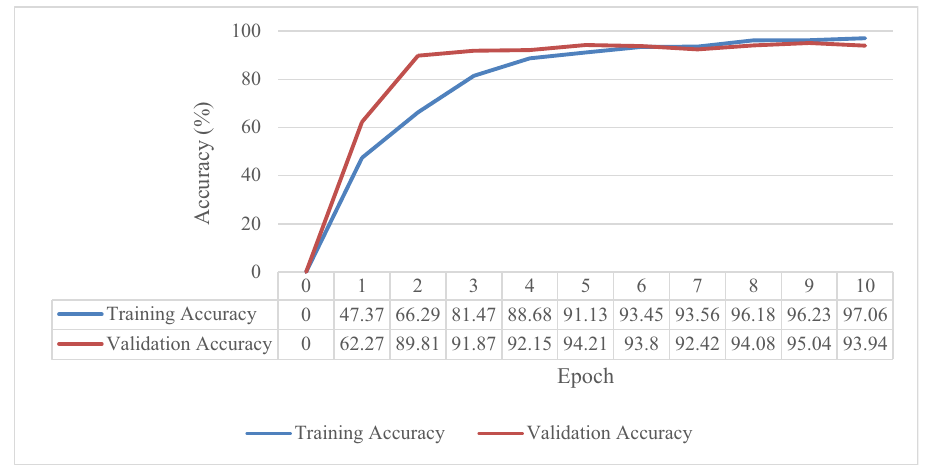
Figure 8: Plotting of the accuracy of training ( training ) and validation ( validation ) on 10 epochs using the pre - trained Xception